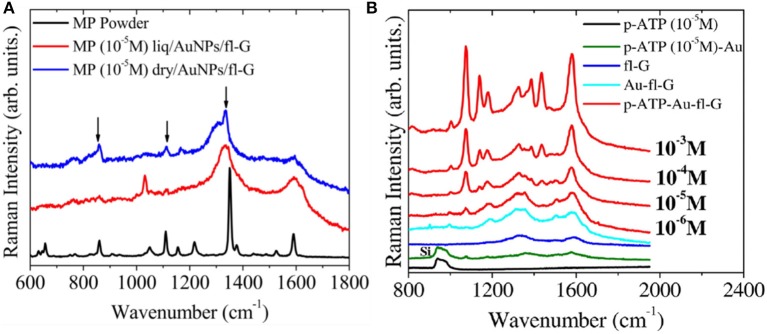
(A) Raman spectra at 633 nm of methyl parathion (MP) on Au-fl-G concentrated at 10–5 M and 10–4 M at liquid and dry states. (B) Raman spectra at 633 nm of p-ATP(10–5 M) on Si, p-ATP(10–5 M) on AuNPs deposited on Si, fl-graphene, AuNPs/fl-G, and p-ATP on AuNPs/fl-G at different p-ATP concentration (10–6 M, 10–5 M, 10–4 M, 10–3 M) [Reproduced from Tite et al. (2016) with permission of Elsevier].